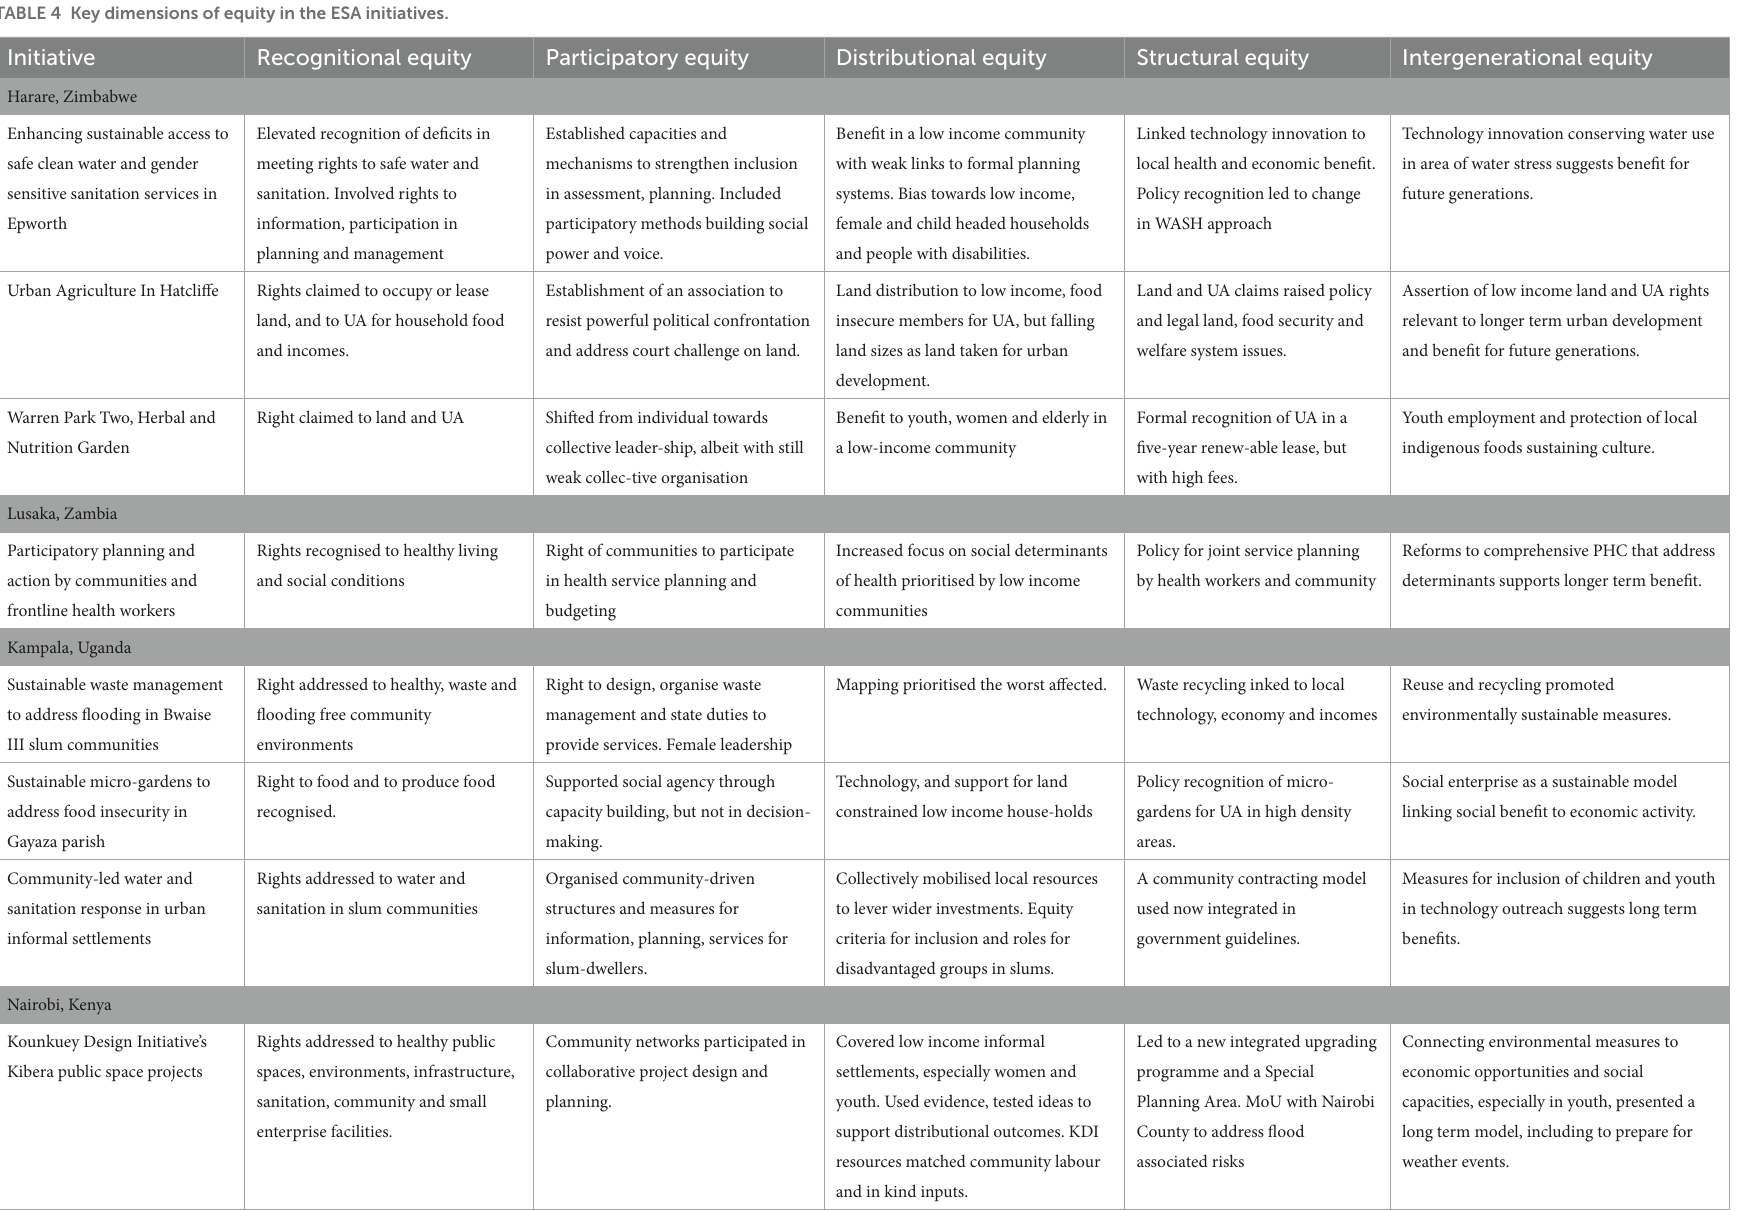
TABLE 4 Key dimensions of equity in the ESA